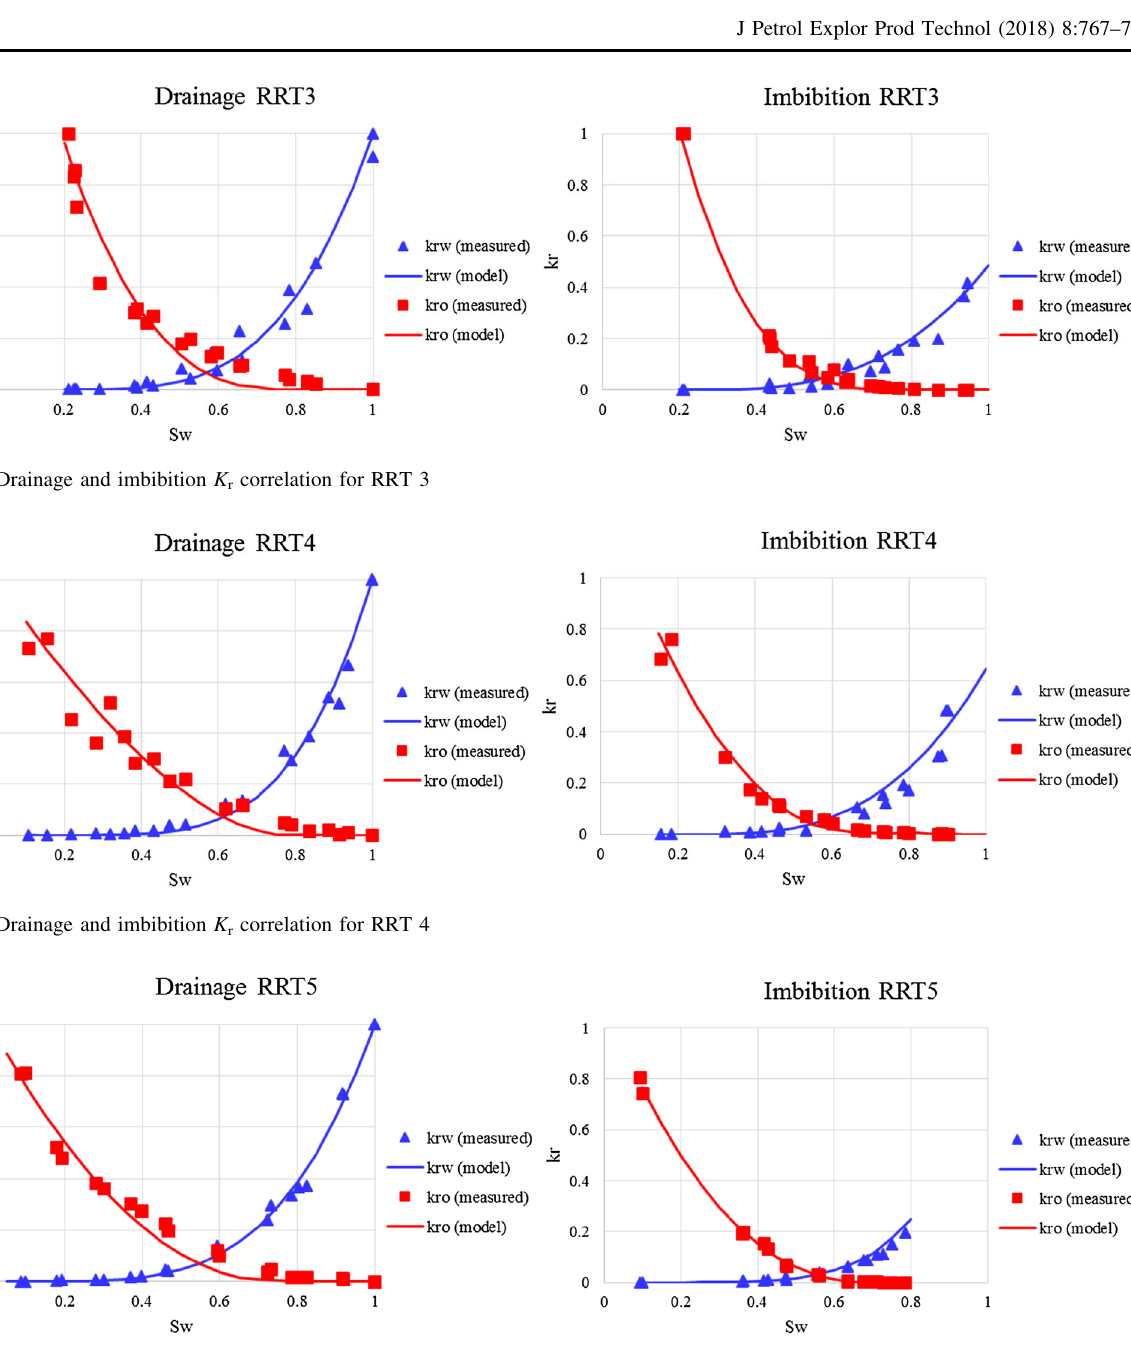
Fig. 24 Drainage and imbibition K r correlation for RRT 5